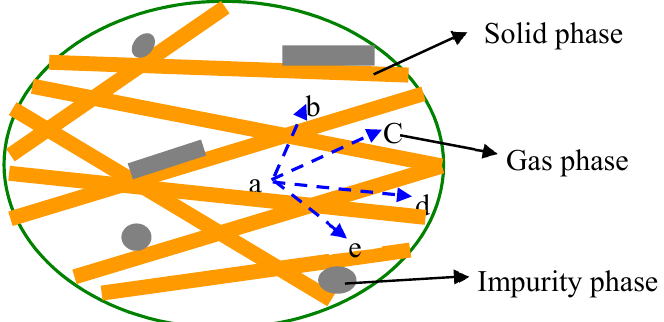
Figure 7. Multiphase medium model for straw core material [23].